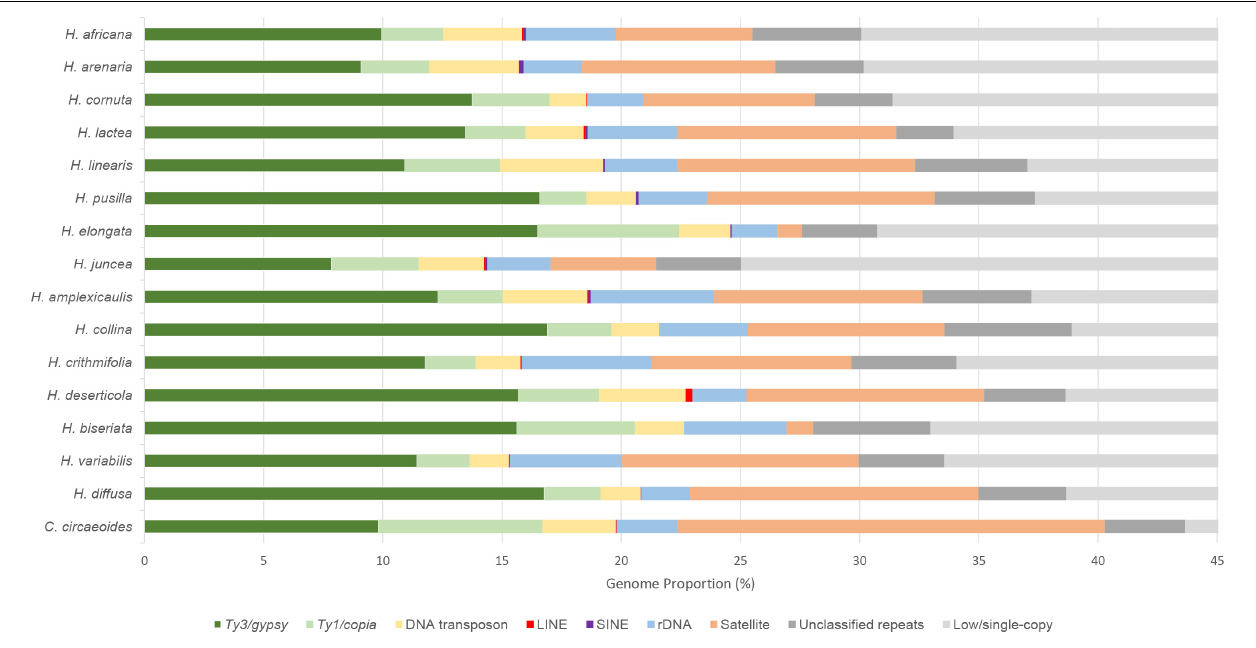
FIGURE 3 | Relative repeat abundances and low/single-copy sequences identified in sequenced genomes of 15 Heliophila species and C. circaeoides . Low/single-copy sequences above 45% were